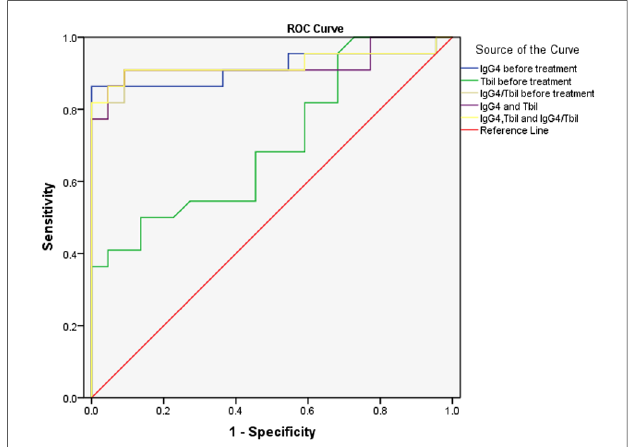
FIGURE 1 ROC analysis of IgG4 level before treatment and tbil level before treatment in the diagnosis of AIP. ROC, receiver operating characteristics; IgG4, immunoglobulin G4; Tbil, total bilirubin; AIP, autoimmune pancreatitis.